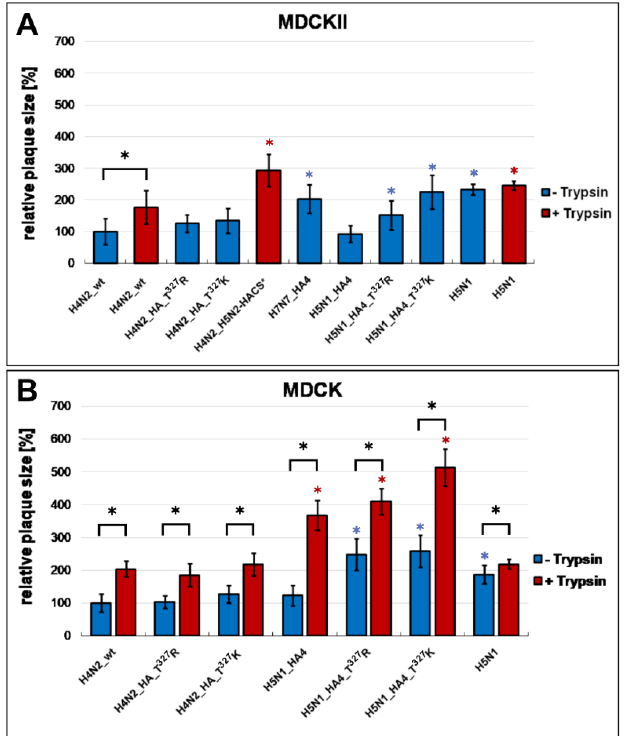
Figure 3. Cell-to-cell spread in MDCKII and MDCK cells . Cell-to-cell spread was assessed by measuring 50 to 100 plaques in MDCKII ( A ) or MDCK ( B ) cells with (T + ) or without (T–) trypsin. In MDCKII ( A ), trypsin was added only to H4N2_wt and H4N2_H5N2-HACS. The latter virus did not produce plaques without trypsin. Results are expressed as mean and standard deviation relative to the plaque size of H4N2_wt in the absence of trypsin. Asterisks indicate significant differences ( p < 0.05); blue and red asterisks